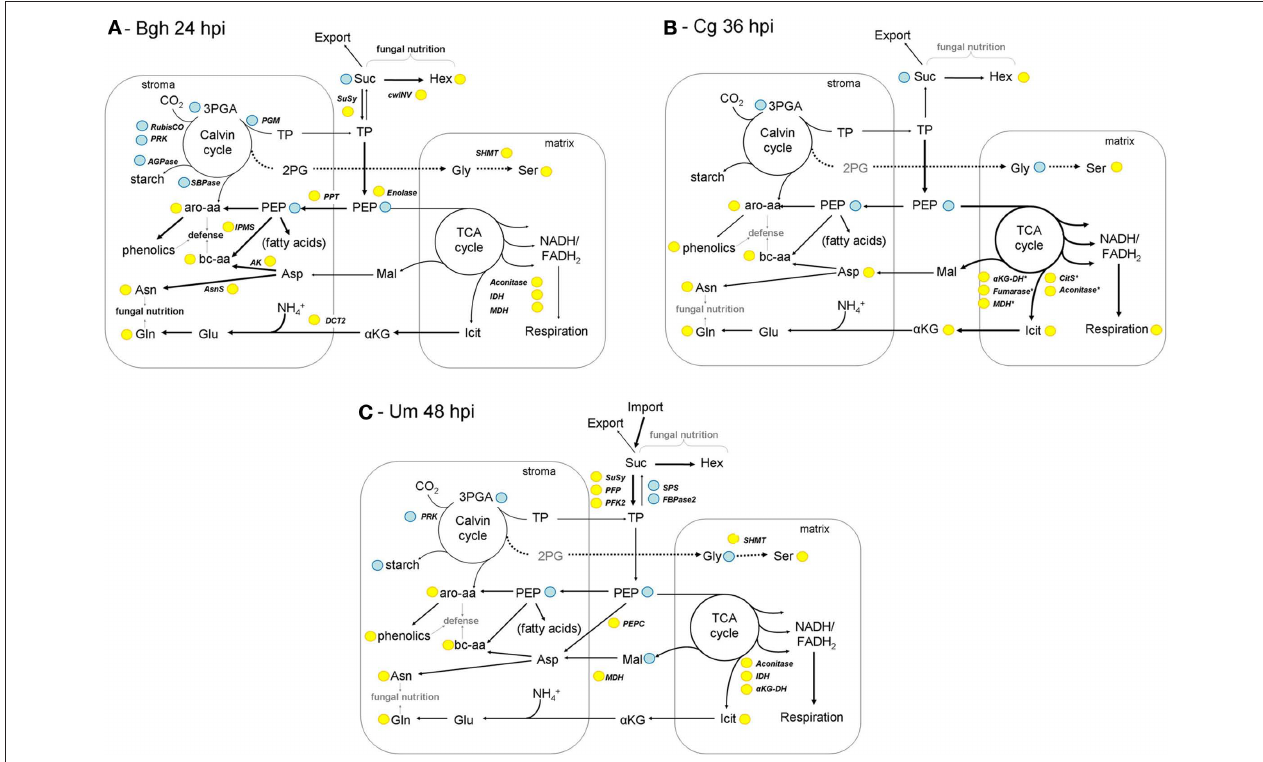
(2-phosphoglycolate); aKG, ( α -ketoglutarate) Hex (hexoses); Icit, (isocitrate); PEP, Figure 7 | Models of leaf metabolism during early interaction stages. Based (phospho enol pyruvate); 3-PGA, (3-phosphoglycerate); Suc, (sucrose); TP on the results of the combined metabolome and transcriptome analysis, models illustrating the reprogramming of host metabolism during early biotrophic interactions are depicted for Bgh infected barley leaves at 24hpi (A) , Cg infected maize leaves at 36hpi (B) and Um infected maize leaves at 48hpi (c) . Please note that for simplicity, C metabolism has been omitted from the maize models. 4 Yellow – up compared to mock control; blue – down compared to mock control. Arrow thickness correlates with the proposed metabolic flux relative to the other depicted metabolic pathways. For explanations, please see the discussion text. Amino acids are abbreviated according to three letter code, 2PG,